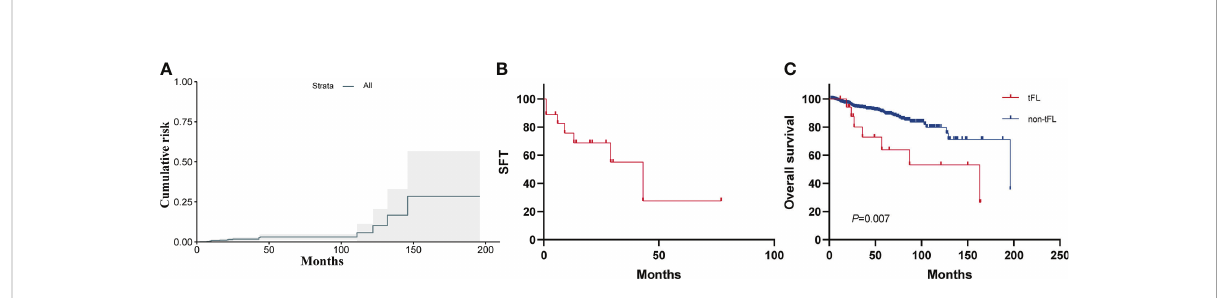
FIGURE 4 (A) Cumulative incidence of histological transformation (CI-HT) as a fi rst event in patients with FL. The shaded area shows the 95% CI. The CI- HT at 5 years was 4.7%. (B) Survival following histological transformation (SFT). Overall 3-year SFT was 55%. (C) OS for patients with or without histological transformation